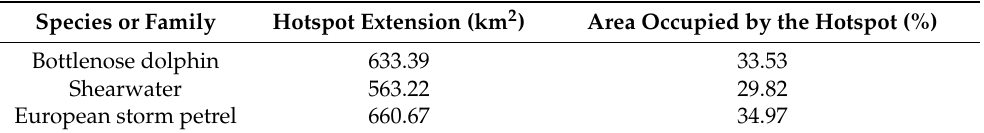
Table 6. Extension and percentage of area occupied by the hotspots (areas with high habitat suitability, red in Figure 6) identified through the MaxEnt algorithm for bottlenose dolphins, shearwaters, and European storm petrels.